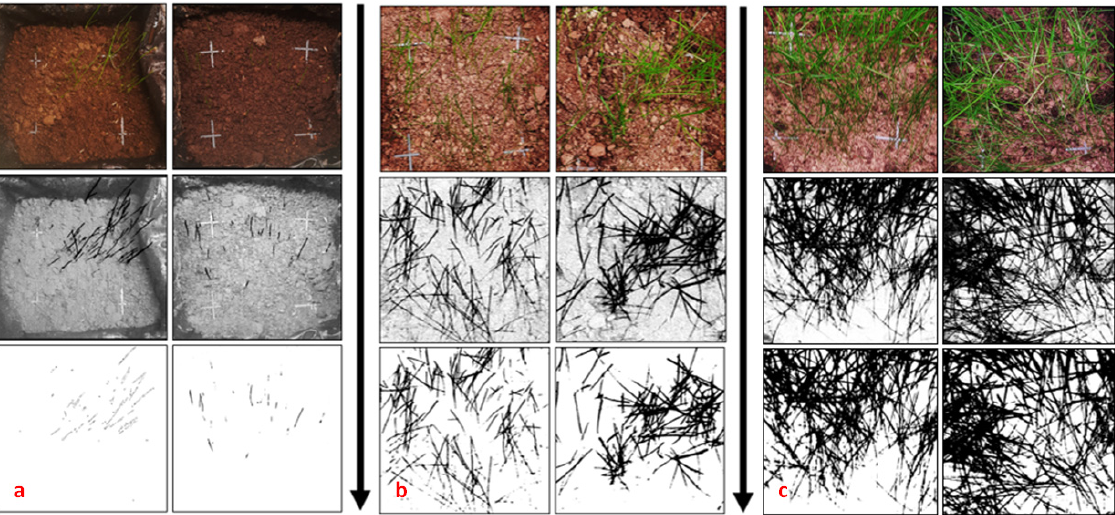
Figure 4. Example of images for digital RGB image processing (in steps) for grass cover in different vegetation stages (1,2,3 weeks): ( a ) RGB image before digital image processing; ( b ) color correction for background removal; ( c ) removal of the background (soil, stones, various inclusions,